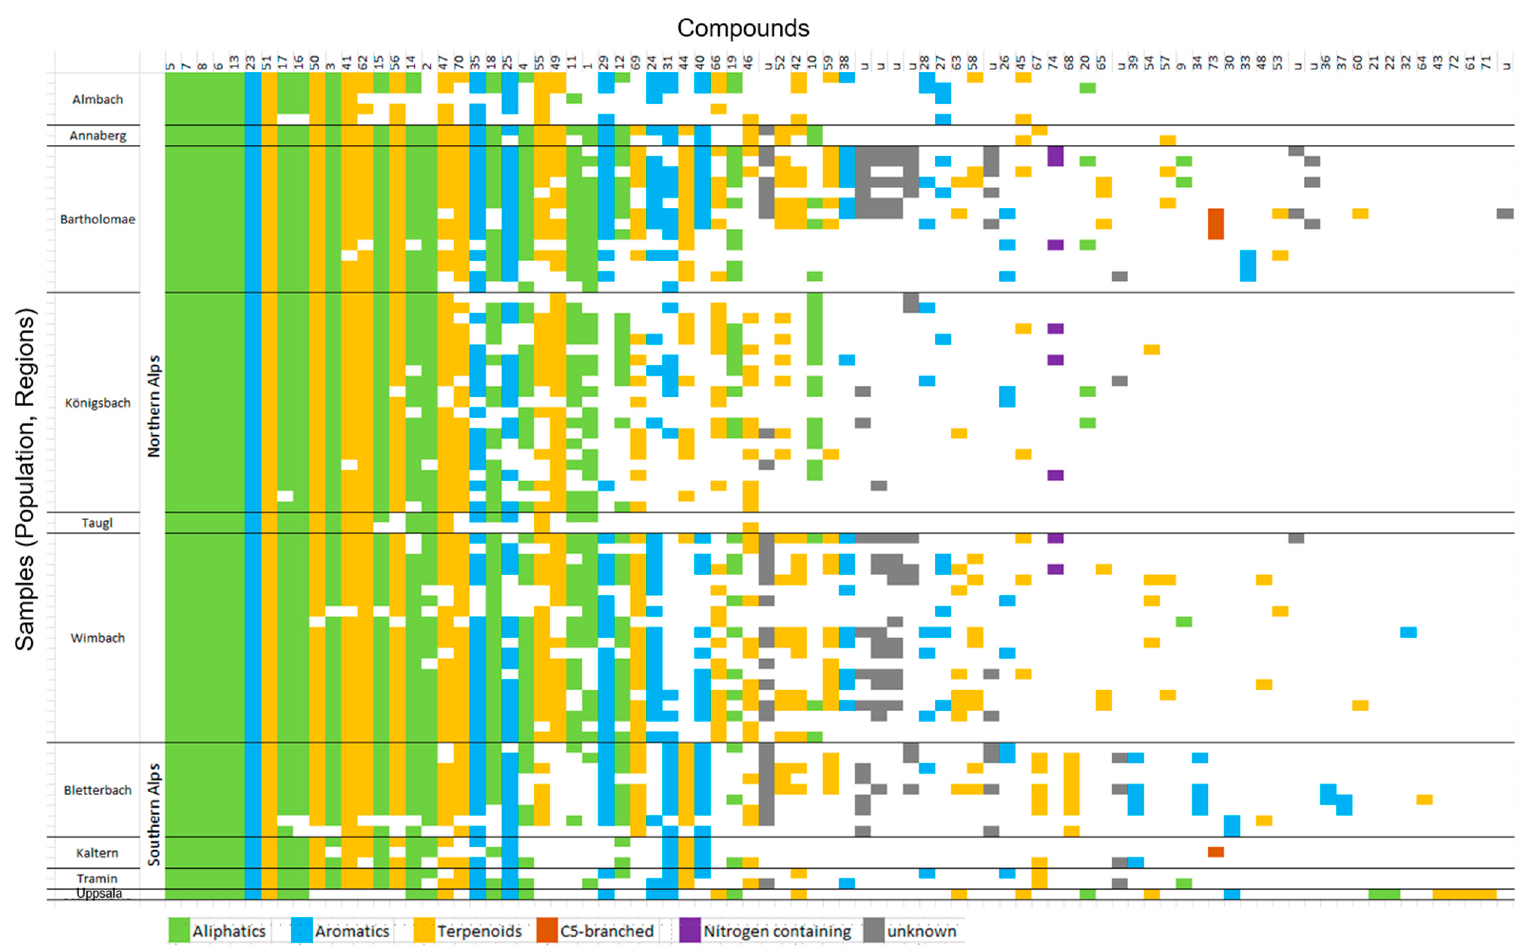
Figure 2. Visualization of presence/absence of all scent compounds in all samples. The scent compounds are numbered on the x–axes (first line) according to numbers in Table 1. Lines on the y–axes represent the samples, with denotation of their populations and regions of origin. The colors represent compound classes. Data from the Northern Alps (except populations Annaberg and Taugl) were from Braunschmid et al. [12], those from Uppsala (Scandinavia) from Bergström et al. [18].